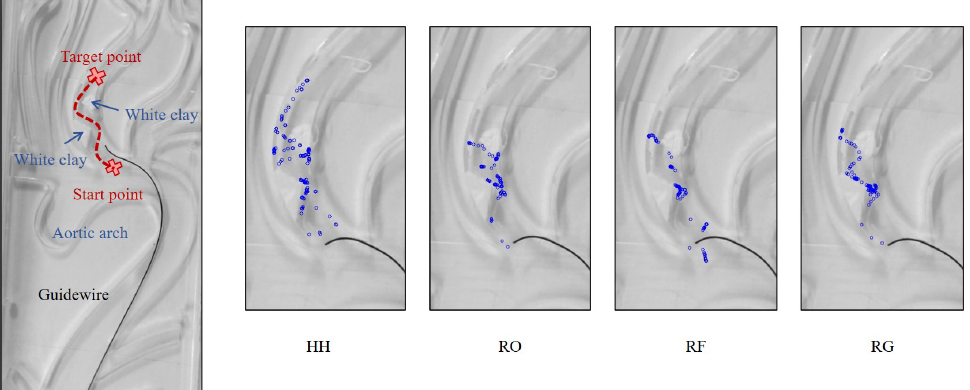
Figure 11. Comparison of surgical